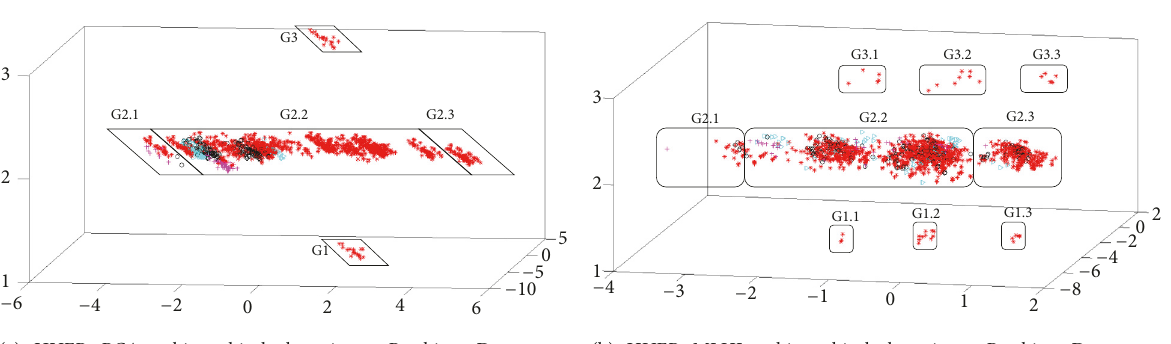
Figure 7: HUEP samples on hierarchical clustering.